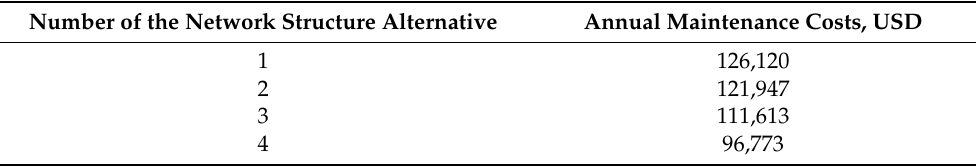
Table 6. Annual maintenance costs of alternative structures of the flexible distribution